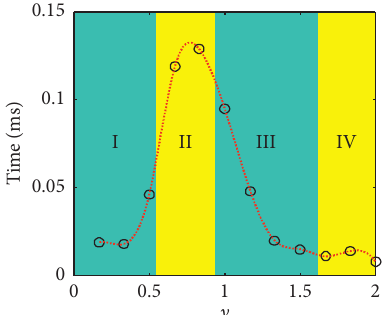
Figure 5: The pulse width data of the bubble load in the first cycle variation diagram for 0.17 ≤ c ≤ 2.00.